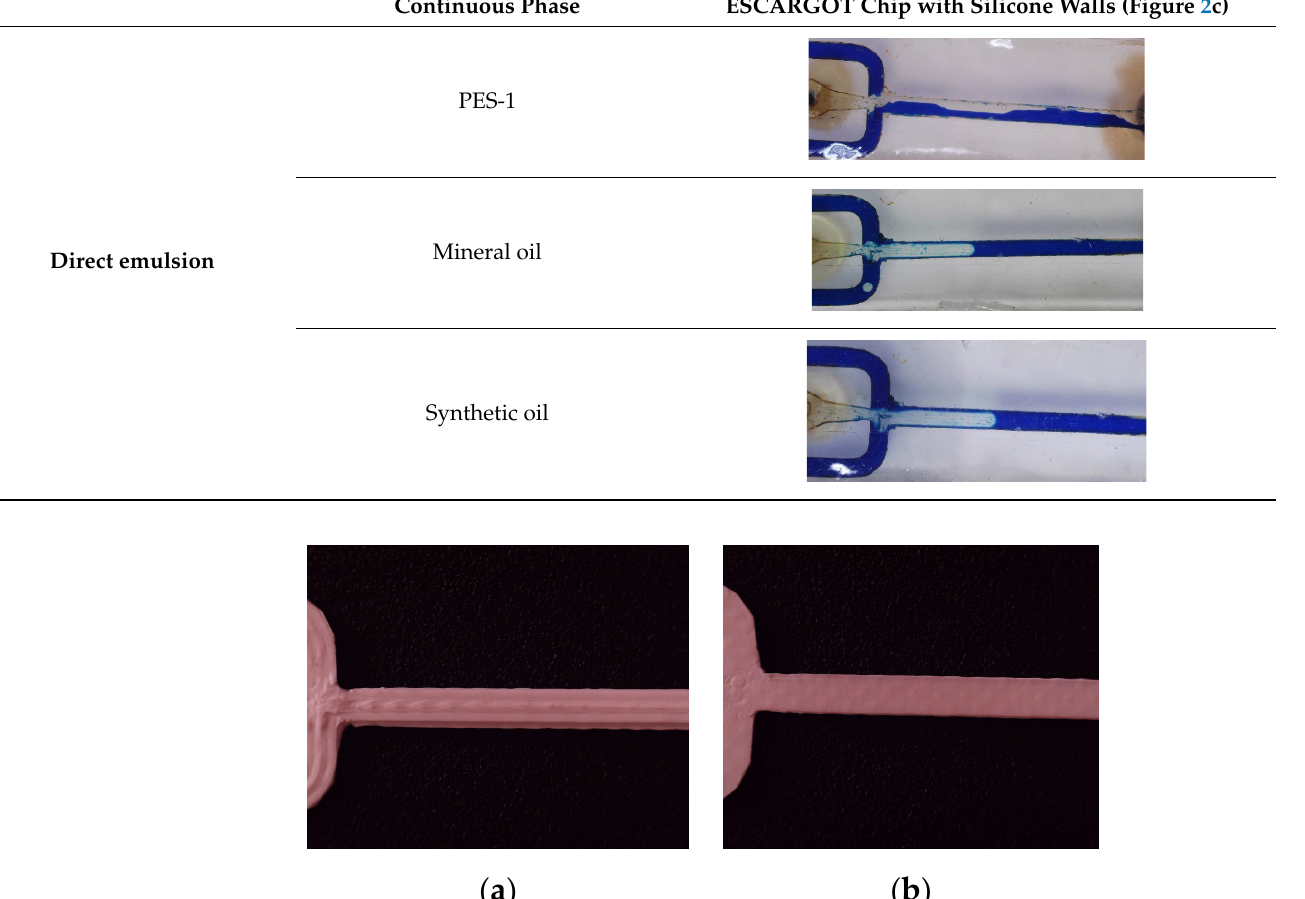
Table 4. The results of the experiment in obtaining a direct emulsion.